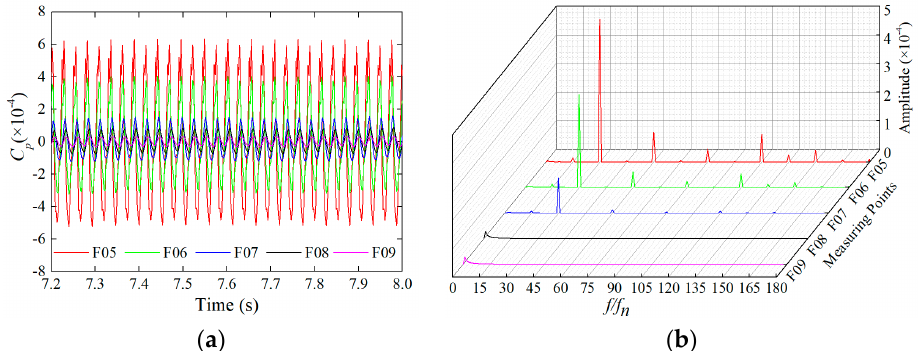
Figure 10. Time and frequency analysis of C p at the measuring points F05~F09. ( a ) Time domain graph, ( b ) frequency domain graph.